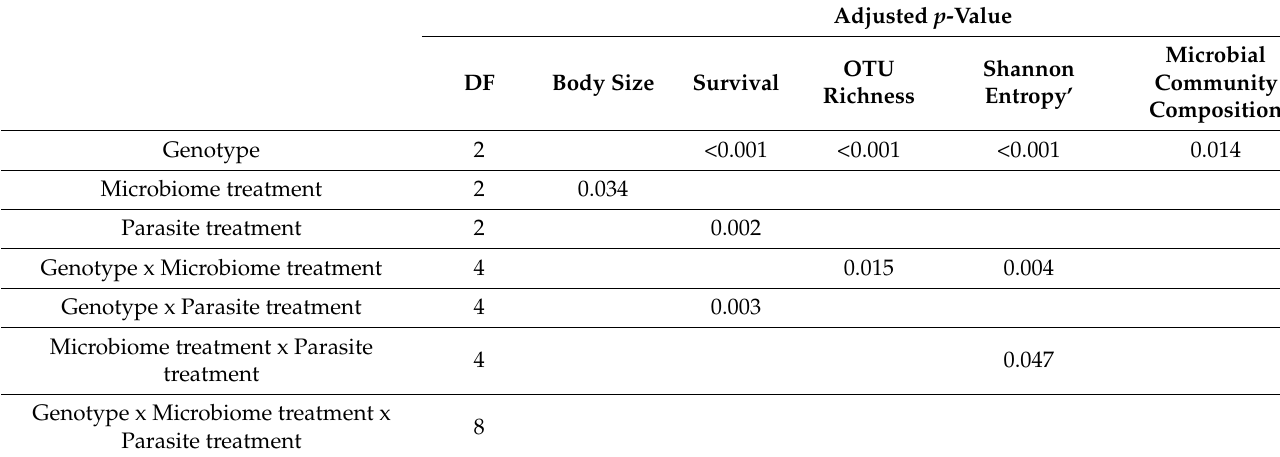
Table 1. Significant results of the statistical analysis on the effect of genotype, microbiome treatment, parasite community treatment, and their interactions on body size, survival, and alpha diversity variables (OTU richness, Shannon entropy’). Degree of freedom (DF) is indicated per main and interaction effect. Obtained p -values were adjusted for multiple comparisons through the control of the false discovery rate